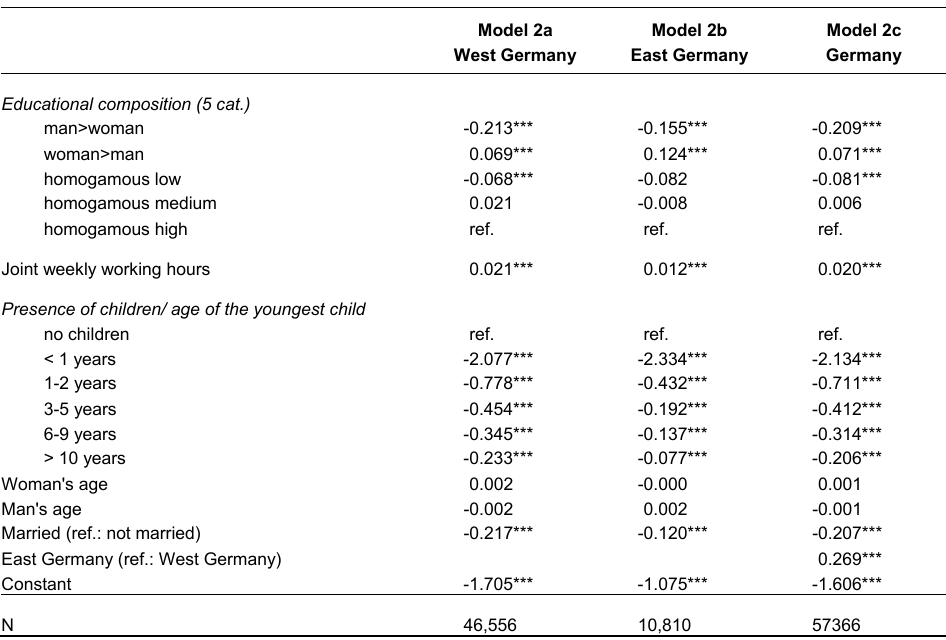
Table A4 : General Linear Models for women’s share of weekly working hours (by region) – educational composition in 5 categories